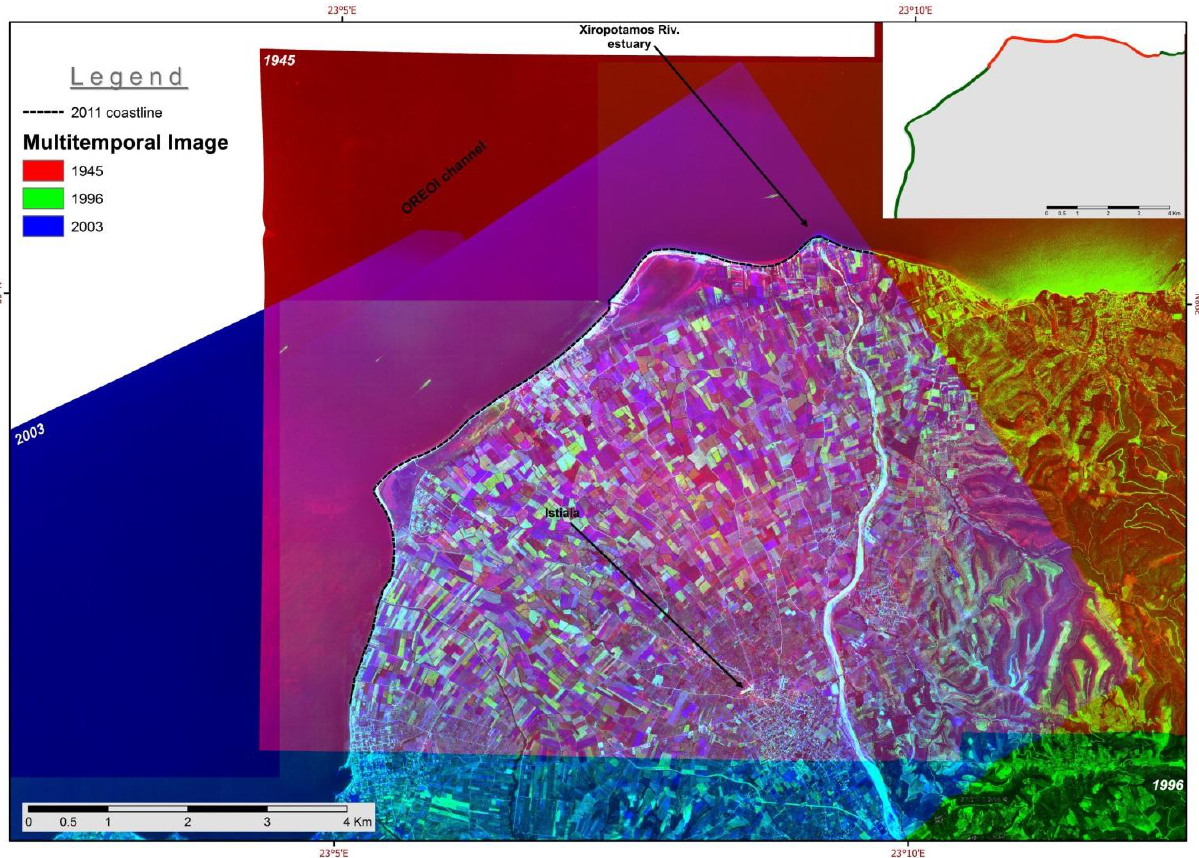
Figure 2. Pseudo-color multitemporal image produced by the combination of three ortho-rectified historic aerial photographs covering the deltaic area, which were used for tracing the coastlines of 1945, 1996, and 2003 (the borders of which are quite clear). The dashed line corresponds to the contemporary coastline (2011). The town of Istiaia, as well as the estuary of the Xirpotamos River are indicated with the black arrows. The inset shows the unstable central coastal area in red, between the generally unchanged segments of the shoreline